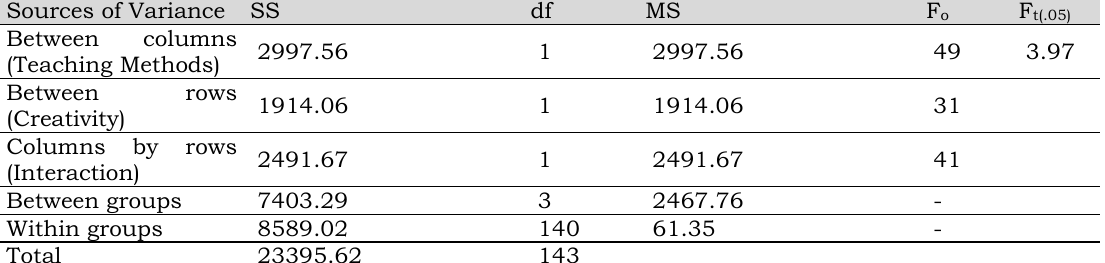
Table 10. The summary result of 2 X 2 ANOVA